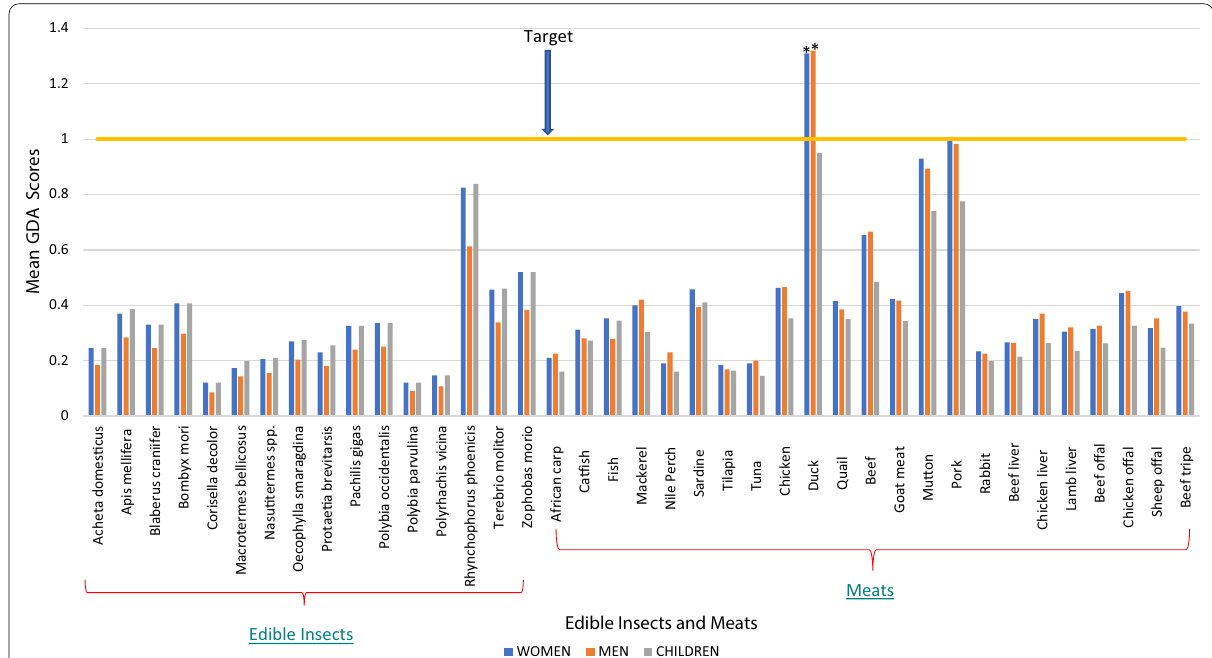
Fig. 3 Clustered column chart showing mean GDA scores for meats and edible insects. *Duck was significantly less healthful than all other foods ( P < 0.0001), except for pork and